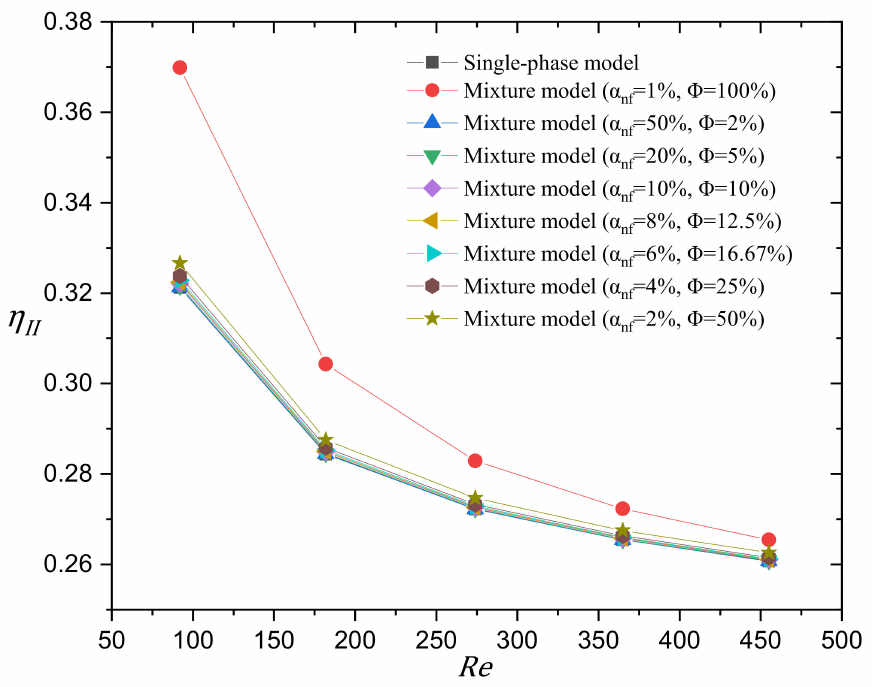
Figure 14. Variation of the minichannel second law efficiency η II over the Reynolds number range 92 to 455. Predictions using the single-phase approach and the two-phase mixture